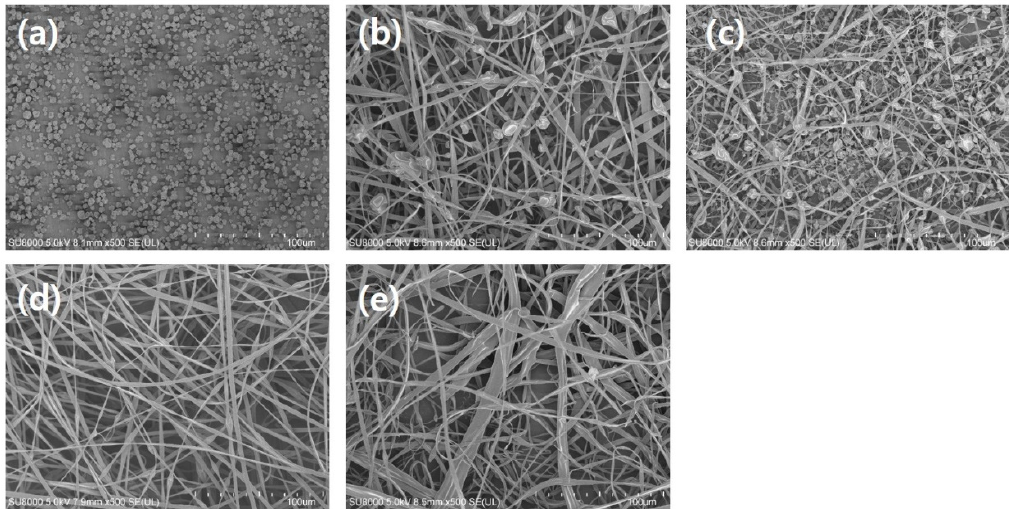
Figure 2. SEM images of electrospun / sprayed poly(FMMA- r -MA)s of ( a ) Poly C0.5, ( b ) Poly C1, ( c ) Poly C1.5, ( d ) Poly C2, and ( e ) Poly C2.5.